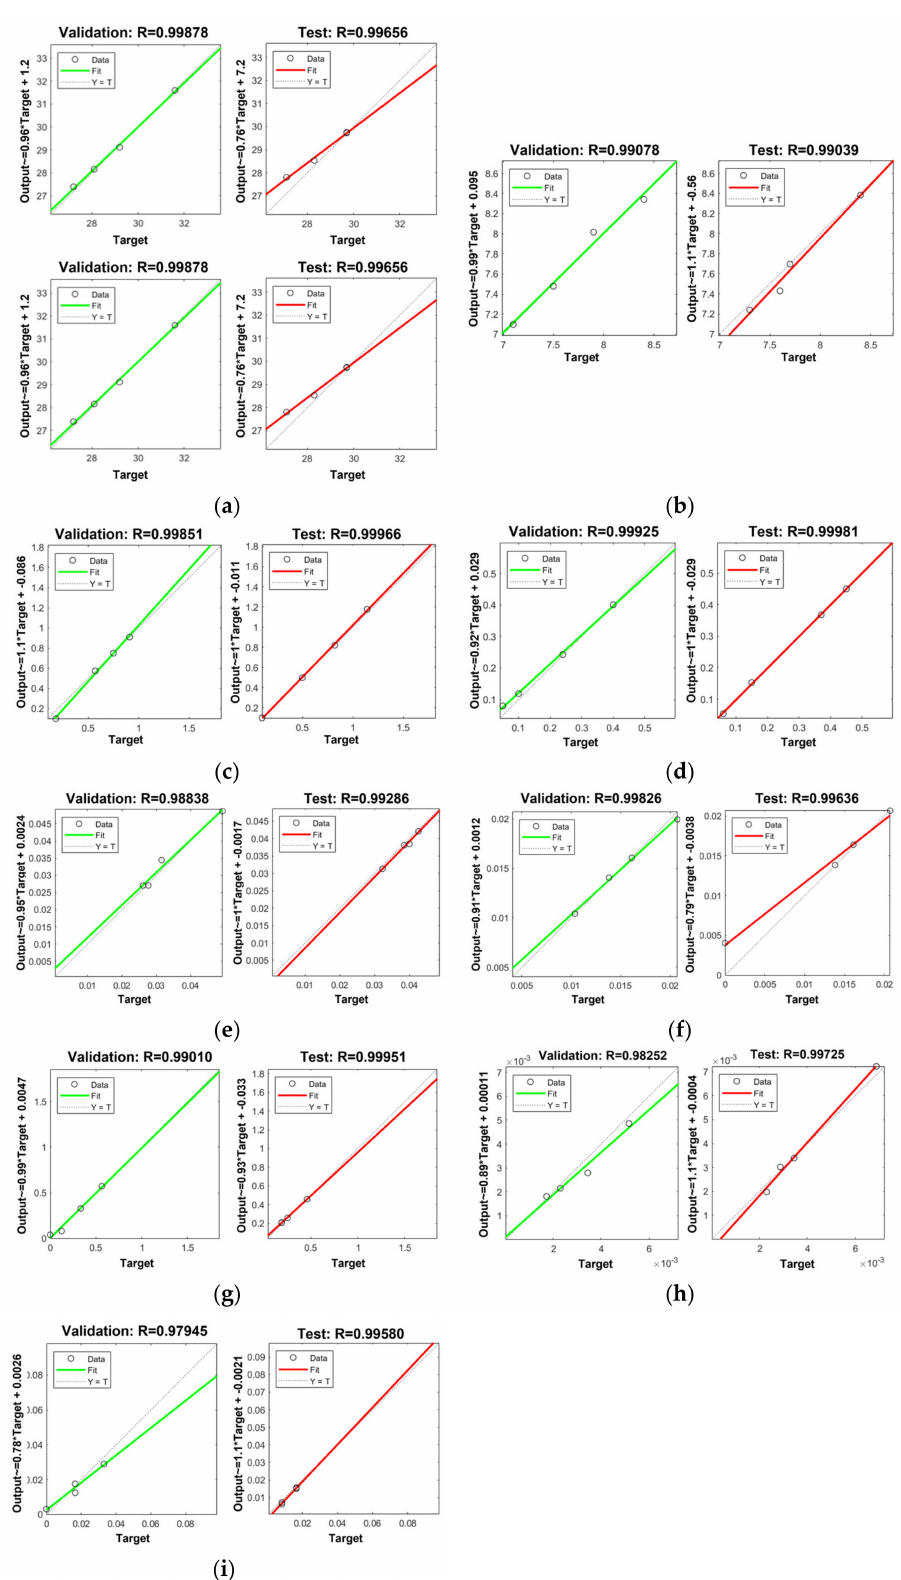
Figure A1. R Value Plots for Validation and Testing Phase of the NN-PSO: ( a ) Temperature; ( b ) pH; ( c ) EC; ( d ) TDS; ( e ) Ba; ( f ) Cu; ( g ) Fe; ( h ) Mn; ( i )